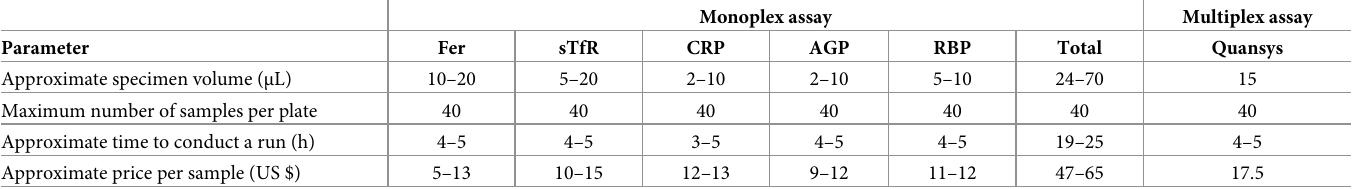
Table 1. Comparison of assay requirements for monoplex vs. multiplex assays a